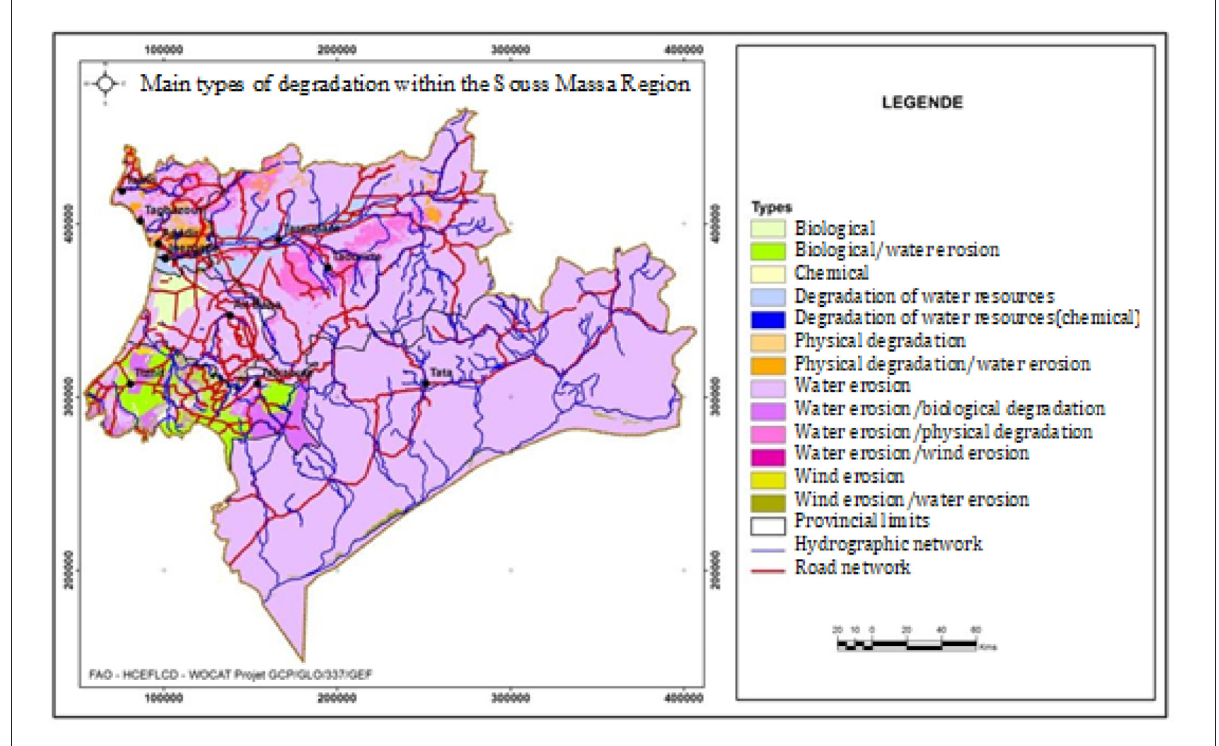
FIGURE7 Main types of degradation within the Souss Massa region.